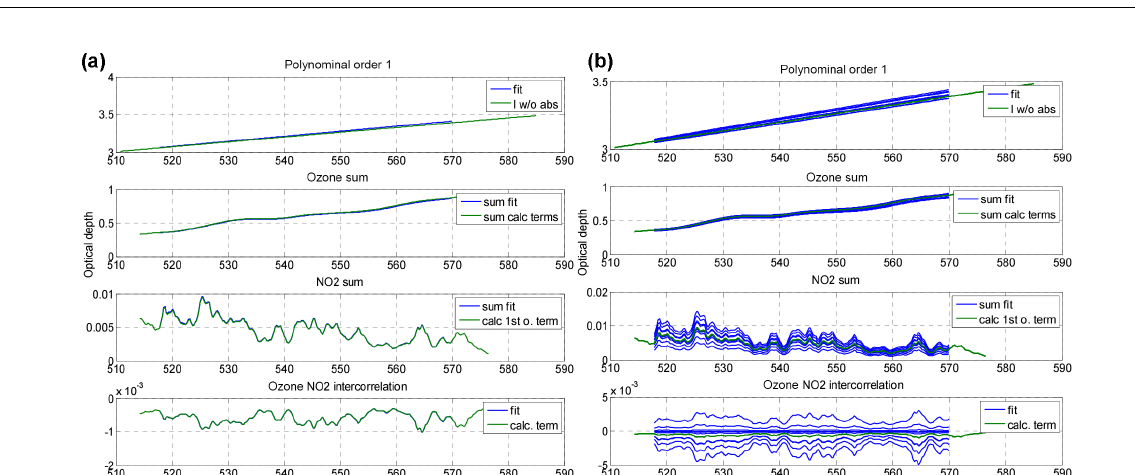
Figure 8. (a) Results for the same evaluation as in Fig. 7, but wherein the fitted ODs are summed according to their attribution to certain trace gases or scattering in Table 1 in comparison with a calculation from the simulated terms at zero absorption (formulae in the right column in the table). (b) The same as (a) but the retrieval is performed with random Gaussian noise added to the simulated spectra. The noise leads to an increase of the fit residual by 10 times when compared to the fit in Fig. 7. The results are shown for 10 different random noise spectra.